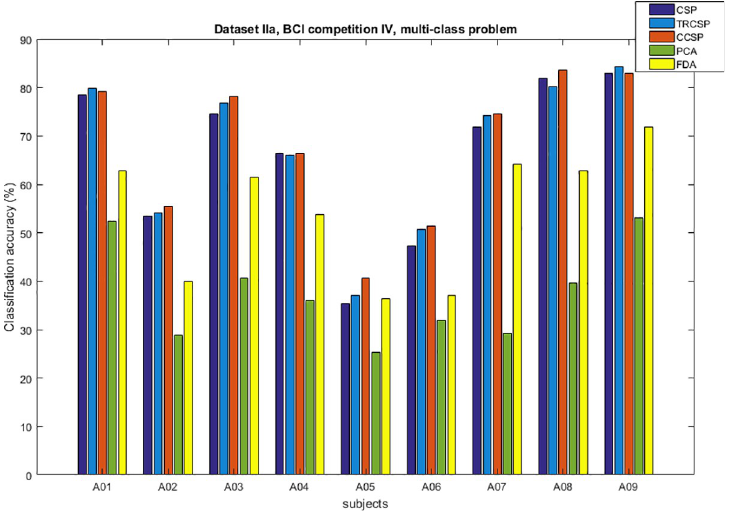
Fig 6. Comparison between classification accuracy of methods for multi-class problem in dataset IIa, BCI competition IV.